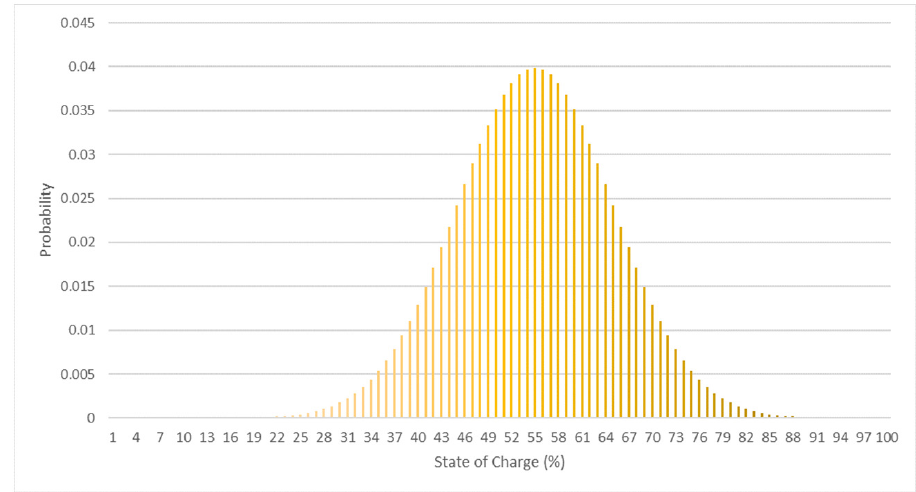
Figure 3. Arriving PEV state of charge probability.